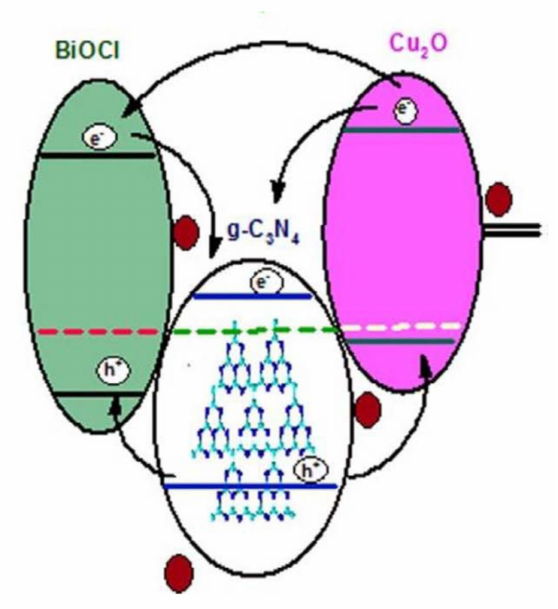
Figure 12. Proposed mechanism of quaternary heterojunction of BiOCl/g-C 3 N 4 /Cu 2 O/Fe 3 O 4 . Reproduced with permission from Kumar A et al, Chemical Engineering Journal; published by Elsevier BV,